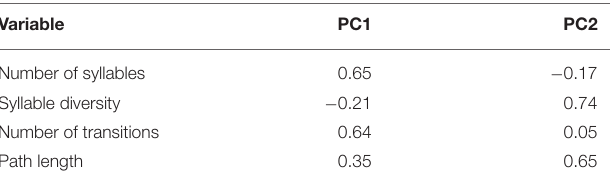
TABLE 3 | Principle Component Analysis (PCA) loading values for troupial song composition data. Variable PC1 PC2 Number of syllables